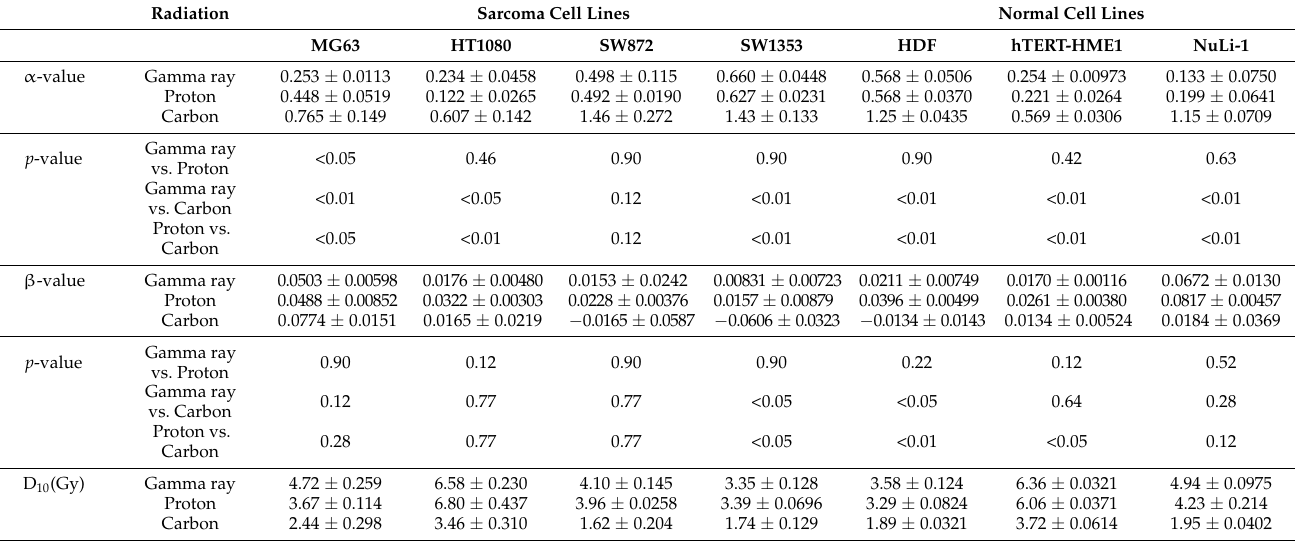
Table 1. Biological parameters of various sarcoma and normal cell